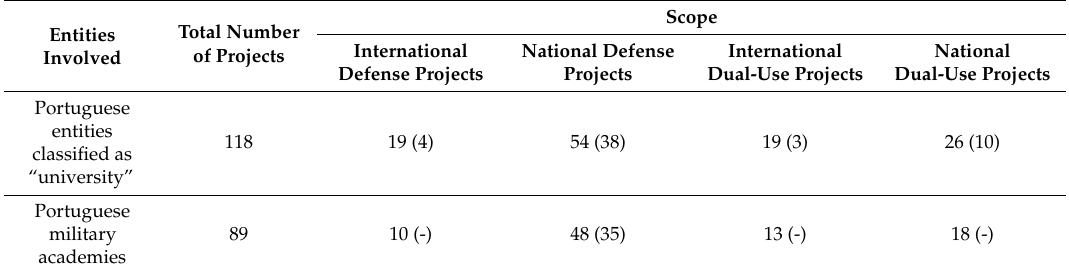
Table 3. Projects with participation and leadership roles of national entities classified as University. Entities